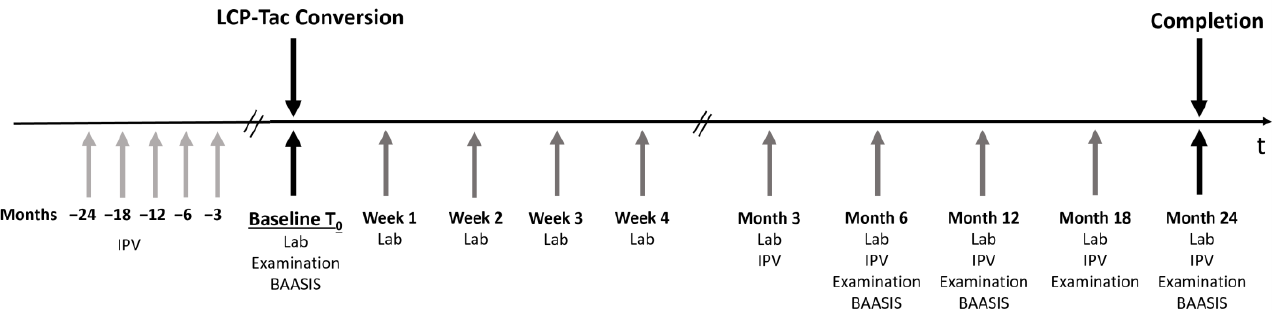
Figure 1. Study design depicting the measurements taken at each time point. IPV values prior to conversion were retrospectively retrieved from patients’ medical record files. Lab = laboratory blood tests, examination = physical examination. BAASIS = Basel Assessment of Adherence Scale to Immunosuppressives